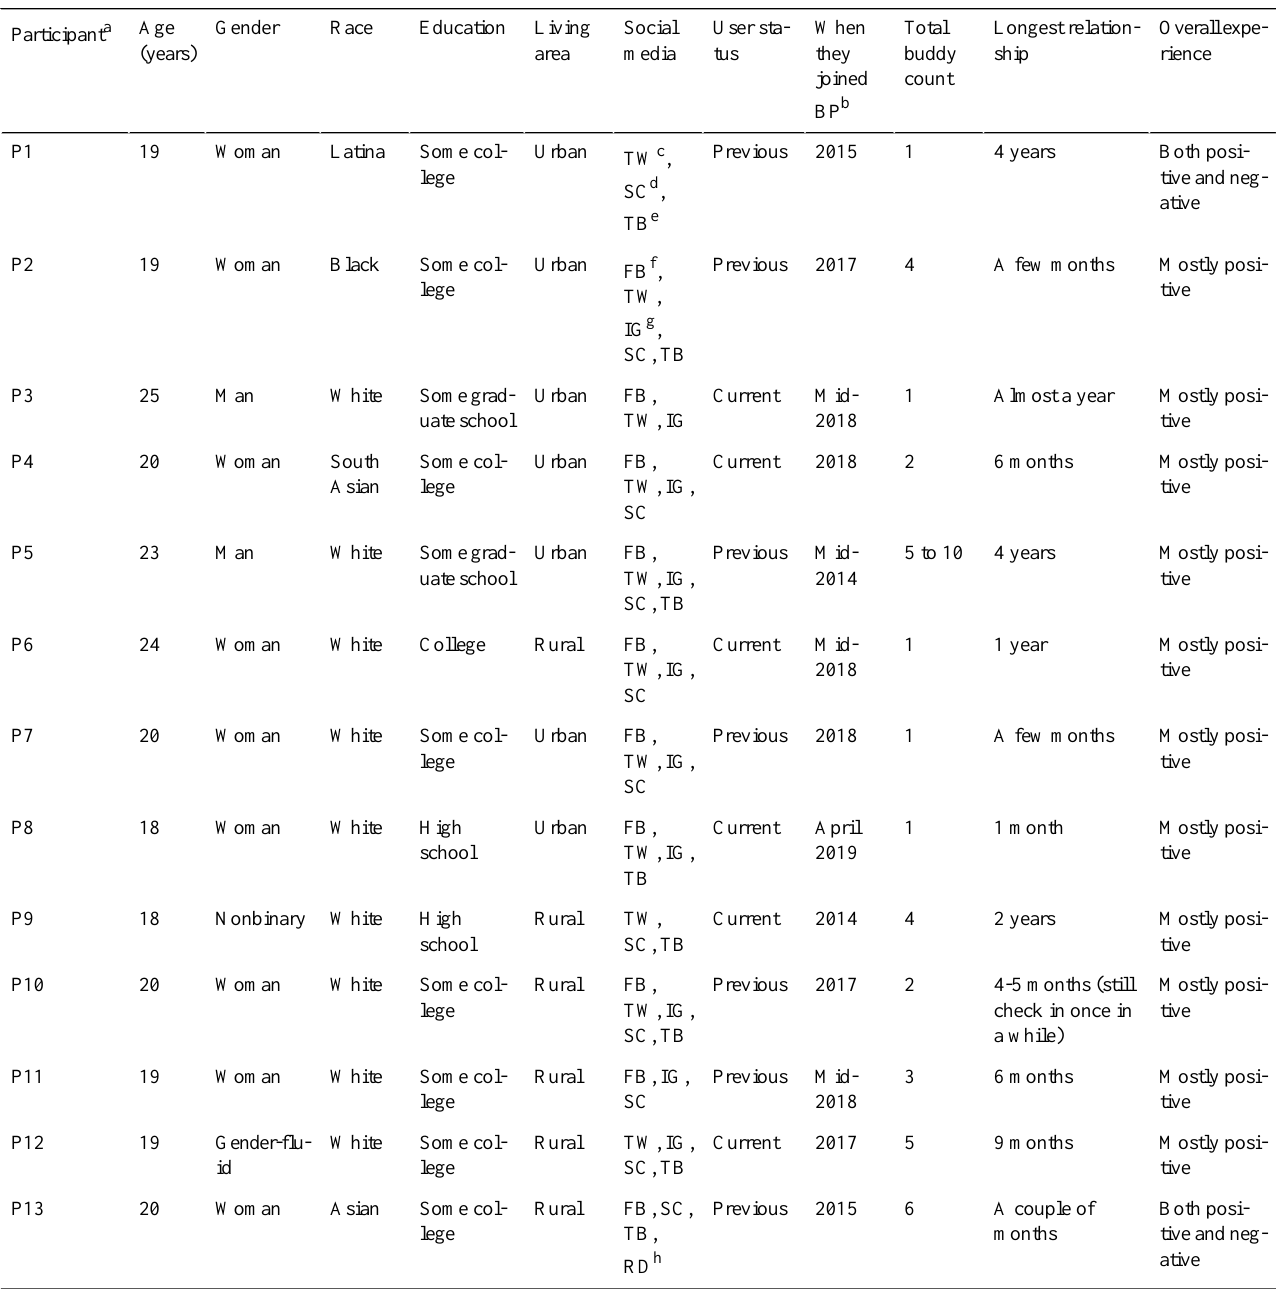
Table 1. Participant